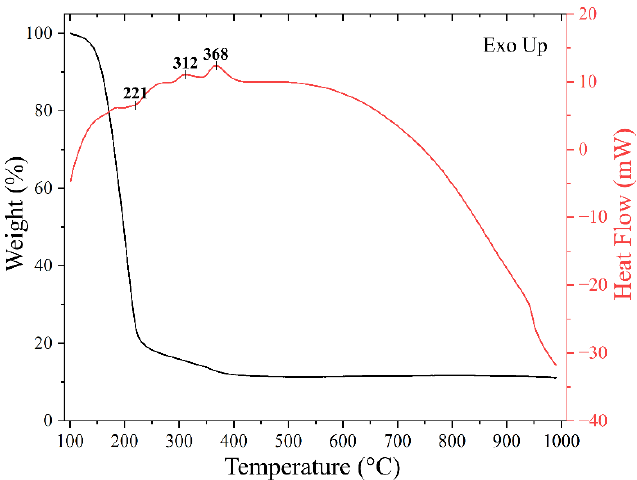
Figure 2. TGA and DSC curves for the precursor solution when heated in an air current in the temperature range 100–1000 °C.